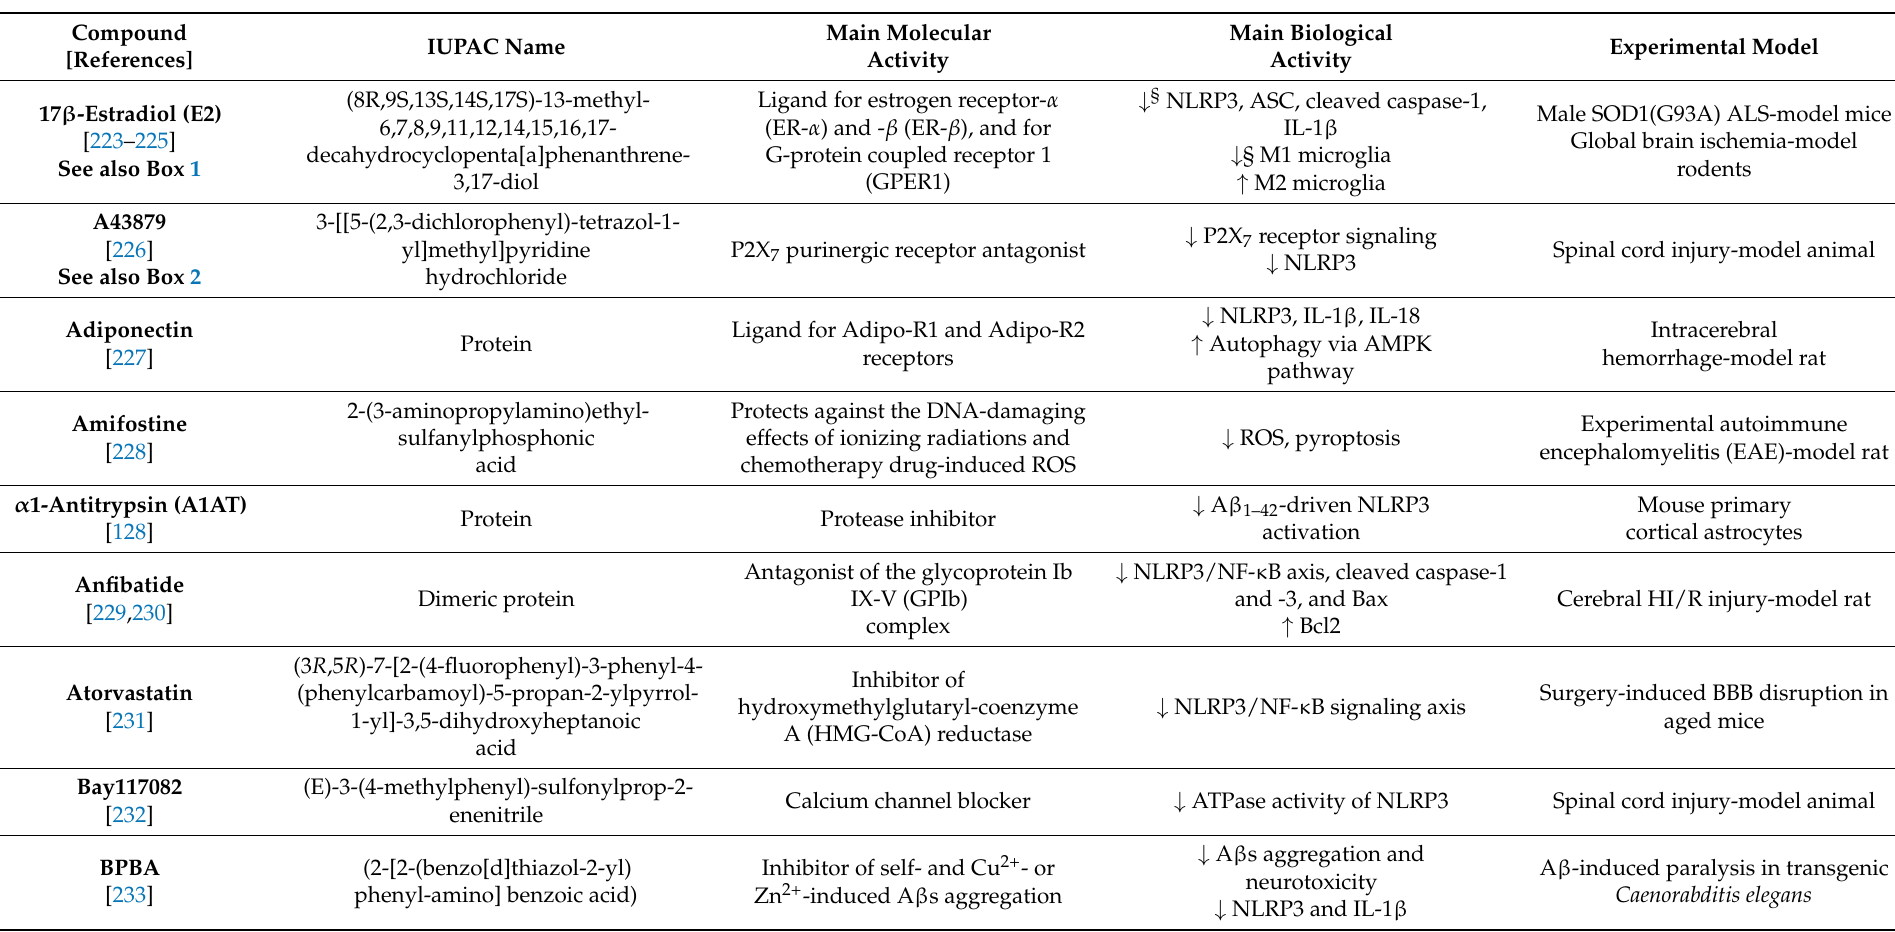
Table 3. Inhibitors of brain NLRP3